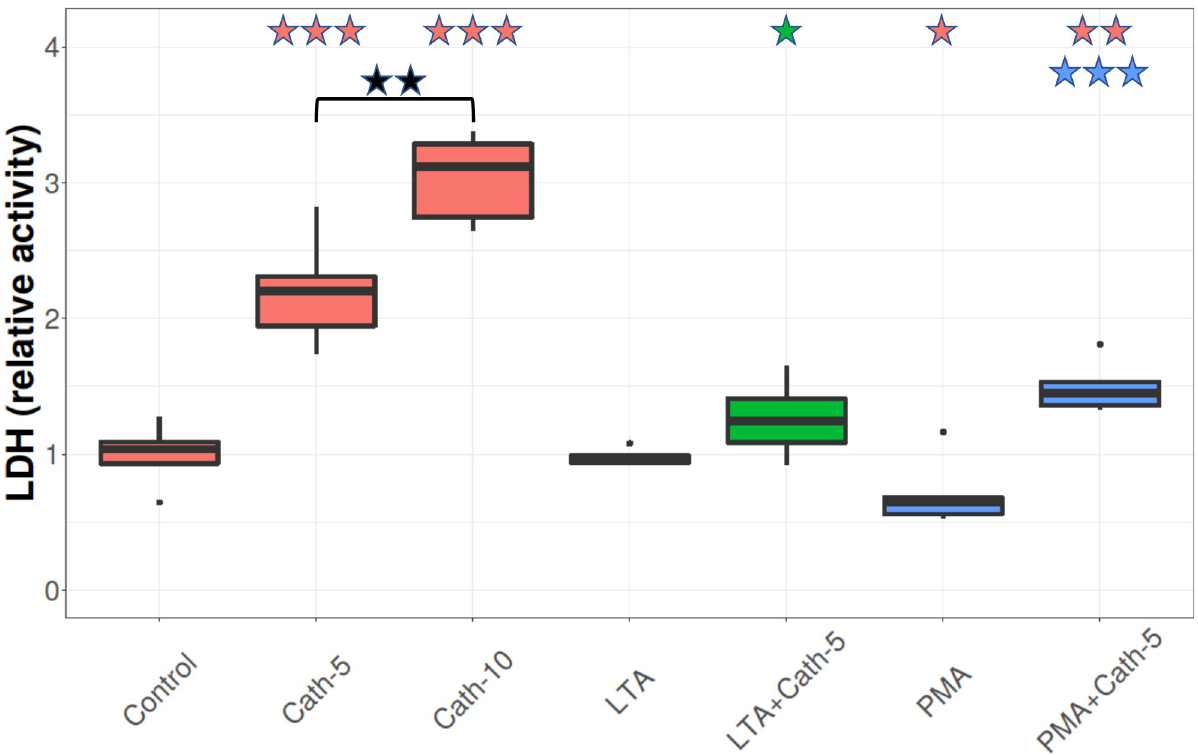
Fig 2. LDH activity. Boxplots showing the lactate dehydrogenase activity for hepatocyte—non-parenchymal cell co-cultures treated with chicken cathelicidin-2 (Cath), lipoteichoic acid (LTA), or phorbol myristate acetate (PMA) only, or the combination of Cath and LTA or PMA (n = 6/group). Results are displayed as relative activity, where 1 is the mean value of control cultures. Cath-5 = 5 nmol/mL Cath, Cath-10 = 10 nmol/mL Cath, LTA = 50 μ g/mL Staphylococcus aureus LTA, PMA = 1000 ng/mL PMA. The Control refers to absolute control cells that received none of the treatments. Red asterisks over the boxes refer to significant differences compared to control cells, green asterisks to the group treated only with LTA, blue asterisks to the group treated only with PMA, and black asterisks between the two concentrations of Cath. � p < 0.05, ��� p < 0.001.